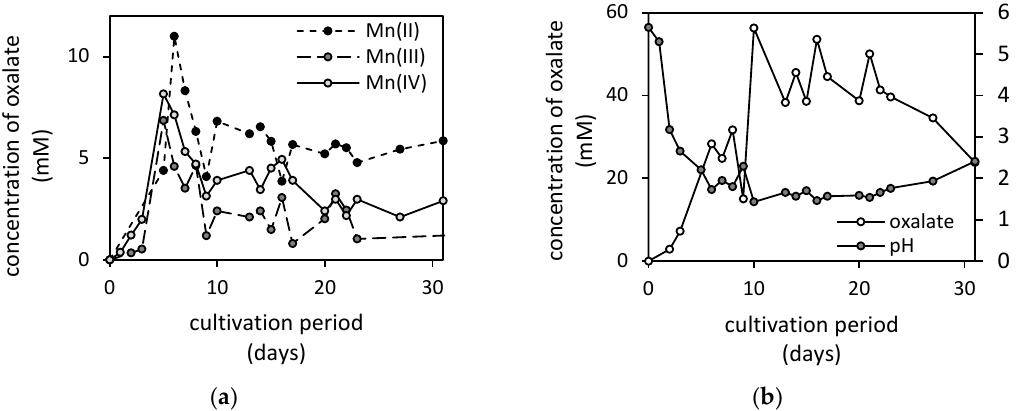
Figure 5. Changes of oxalate concentrations in culture media supplemented with ( a ) Mn(II); Mn(III) and Mn(IV)-oxides, and ( b ) changes of pH and oxalate concentrations in manganese-free treatment (control) during a 31-day cultivation of fungus Aspergillus niger .